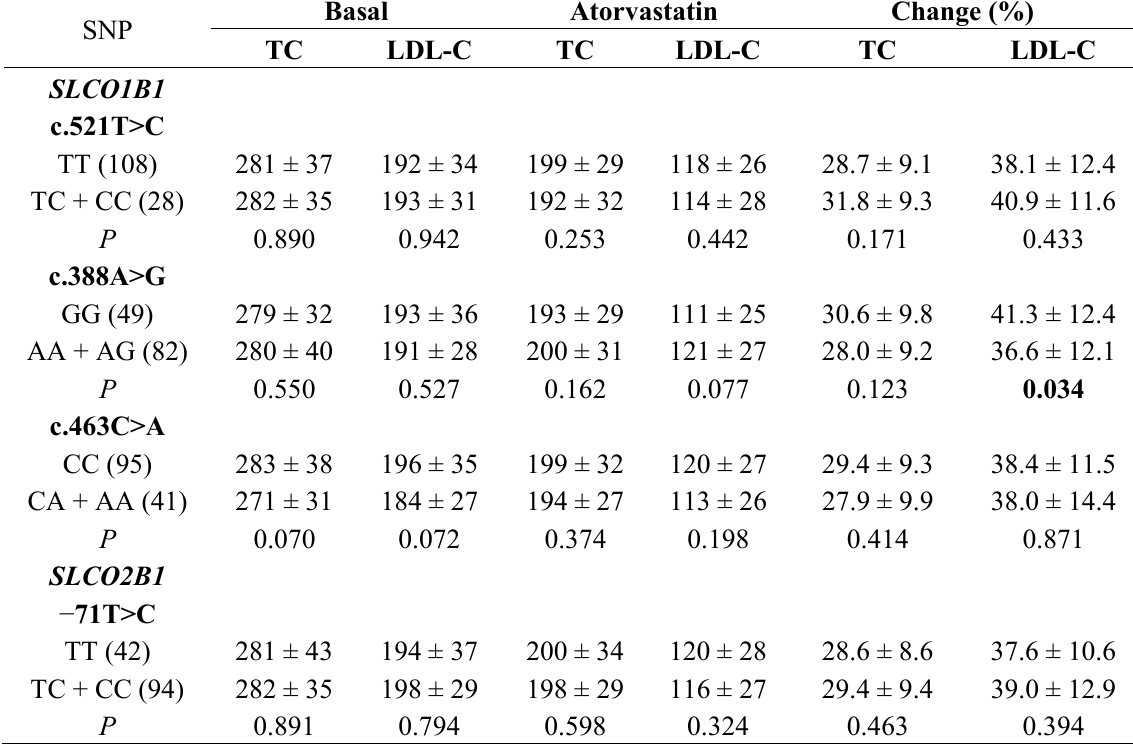
Table 2. Association of SLCO1B1 and SLCO2B1 variants with total and LDL cholesterol in individuals treated with atorvastatin. Basal SNP